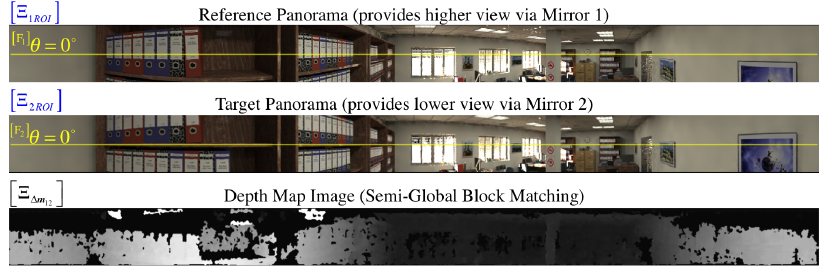
Figure 15. For the synthetic omnidirectional image [ I ] shown in Figure 2b, we generate its pair of panoramic images ( [ Ξ 1 ] , [ Ξ 2 ] ) using the procedure explained in Section 5.1. Note that we only work on the SROI (shown here) to perform a semi-global block match between the panoramas as indicated in (cid:3) , is visualized at the bottom as a gray-scale panoramic Section 5.1.1. The resulting disparity map, (cid:2) Ξ ∆ m 12 image normalized about its 256 intensity levels, where brighter colors imply larger disparity values. To distinguish the relative vertical view of both panoramas, we have annotated the row position of the